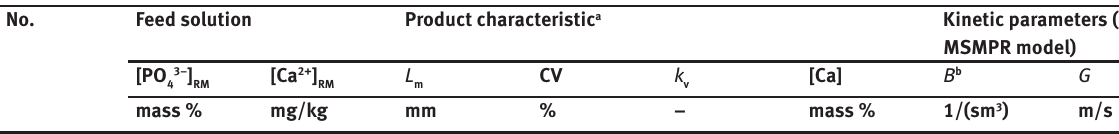
Table 1: Effect of calcium ions on crystal product characteristic [9, 10] and kinetic parameters values [11] of continuous struvite reaction crystallization process. Nucleation rate B and crystal linear growth rate G calculated with SIG MSMPR model. Process temperature: 298 K, pH 9, mean residence time of suspension in a crystallizer τ 900 s.